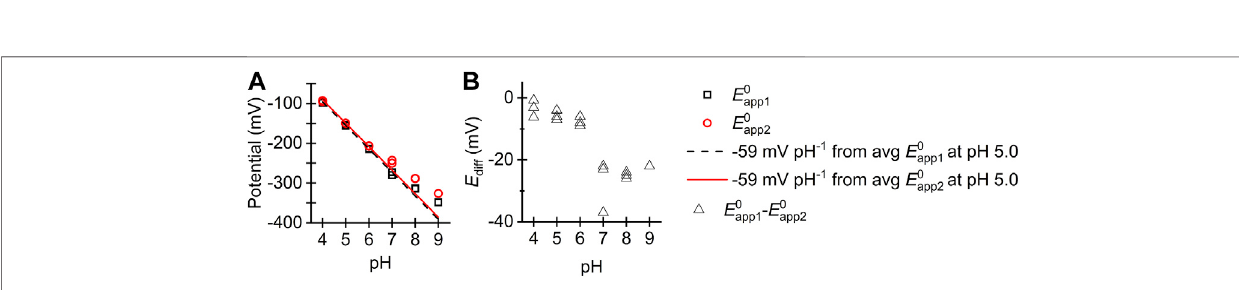
FIGURE6| (A) Plot of(black square) E 0 app 1 and (red circle) E 0 app 2 values from Table 1 vs. pH. Overlaid are − 59 mV per pH lines extrapolated from theaveragepoint values at pH 5.0 for (black dashed line) E 0 app 1 and (red solid line) E 0 app 2 . (B) Plot of difference between best fi t E 0 app 1 and E 0 app 2 values as a function of pH.